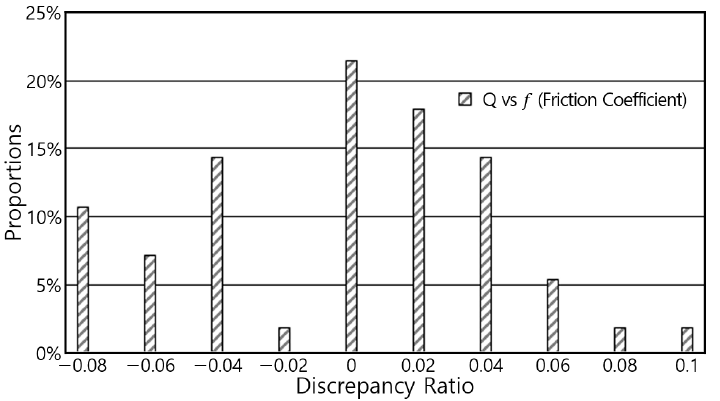
Figure 11. The discrepancy ratio for f and Q calculated using Yuen’s